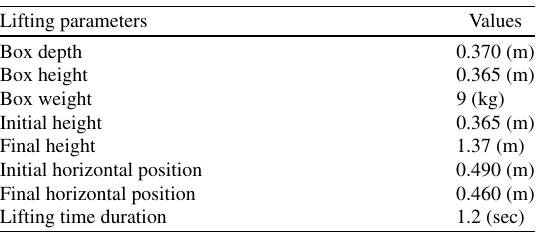
Table 2 Parameters and their values of lifting task Lifting parameters